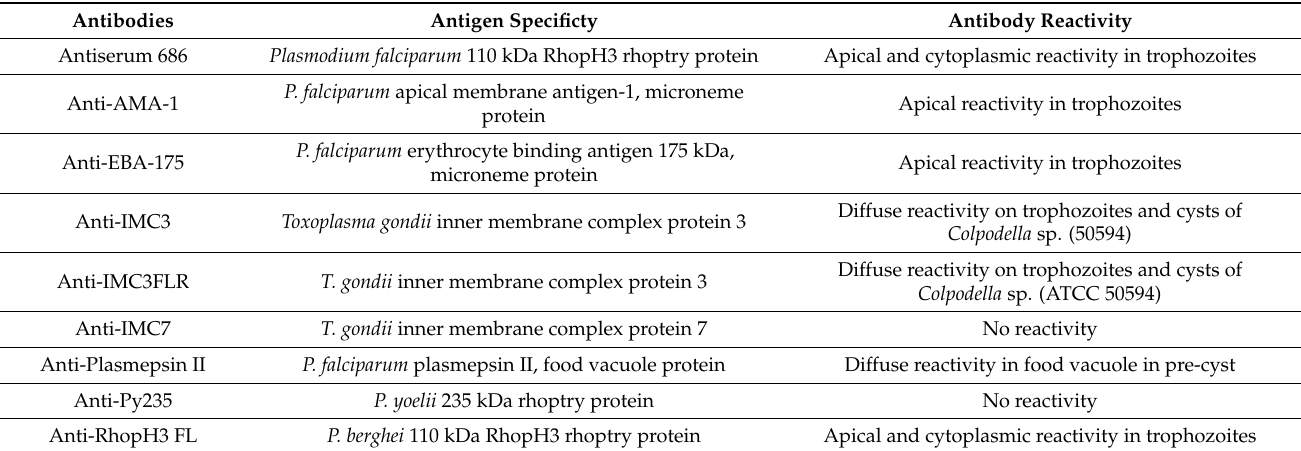
Table 2. Antibodies used in immunofluorescence and confocal microscopy of Colpodella sp. (ATCC